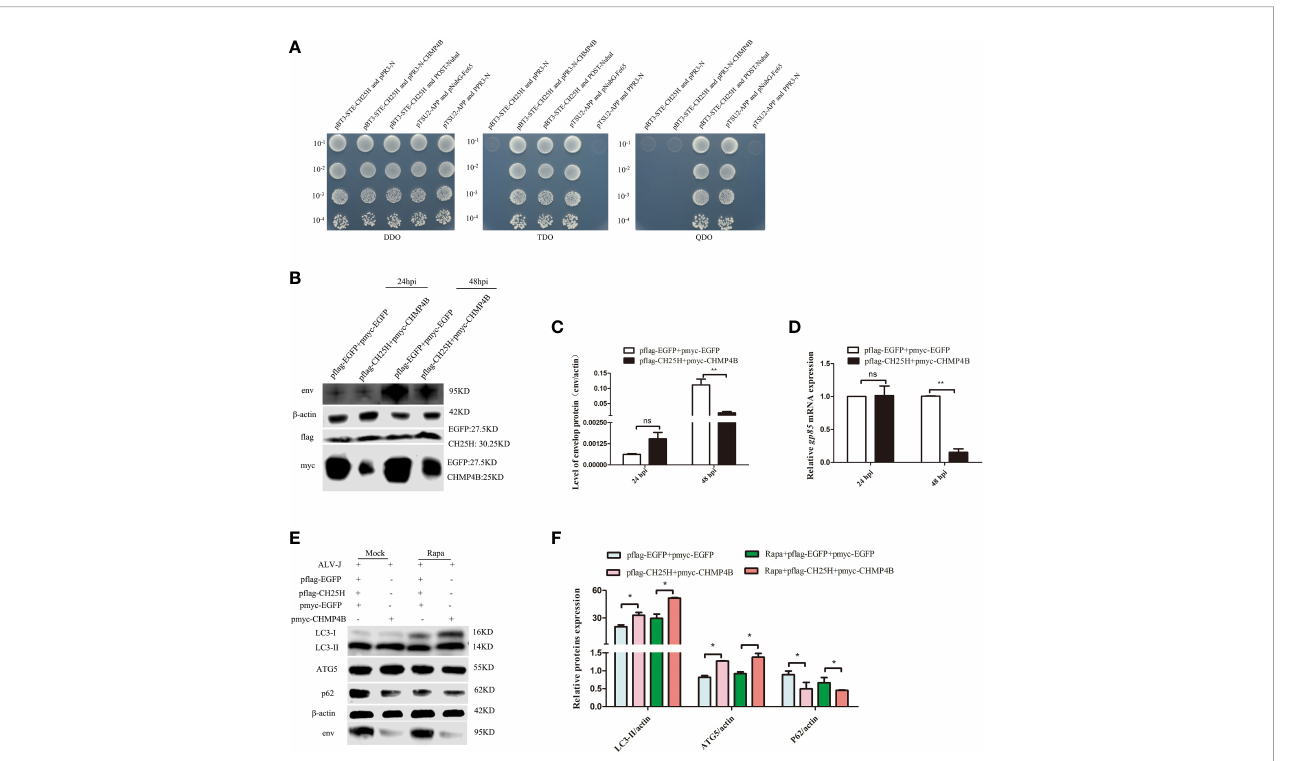
FIGURE 6 CH25H binds to CHMP4B and inhibits ALV-J replication by promoting autophagy. (A) A direct interaction between CH25H and CHMP4B was suggested from Yeast two-hybrid assay. (B-F) DF-1 cells were co-transfected with fl ag-tagged CH25H and myc-tagged CHMP4B plasmids for 24 h, subsequently infected with ALV-J (10 5 TCID 50 /0.1mL). The expression levels ALV-J env, fl ag-tagged CH25H, and myc-tagged CHMP4B were assessed by immunoblot (B) . Relative expression levels of ALV-J env were quanti fi ed based on protein expression levels of b -actin (C) . Relative mRNA levels of ALV-J gp85 were detected by qRT-PCR at the indicated time (D) . (E) The expression levels of LC3II, ATG5, p62, and ALV-J env were analyzed by immunoblot. (F) Quanti fi cation of LC3II/ b -actin, ATG5/ b -actin, and p62/ b -actin were analyzed by Image Studio software. EGFP represents the control. hpi represents hours post infection. Data shown are the means ± SEM of at least two independent experiments. P values were calculated using unpaired Student ’ t -test. A P -values < 0.05 were considered statistically signi fi cant differences, and a P -values < 0.01 were considered highly statistically signi fi cant differences. * P < 0.05; ** P < 0.01, ns: Non-signi fi cant